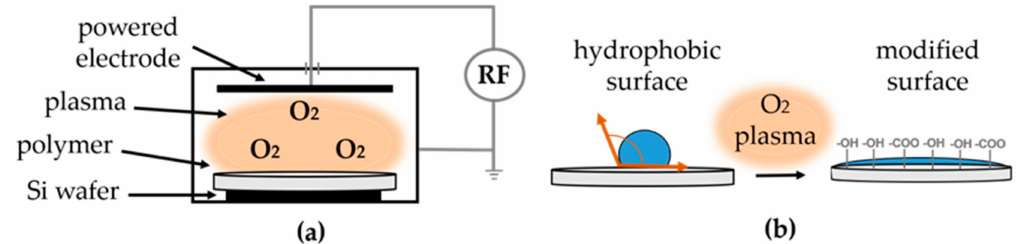
Figure 1. Schematic drawing of the oxygen plasma treatment ( a ) and the resulting modified surface ( b